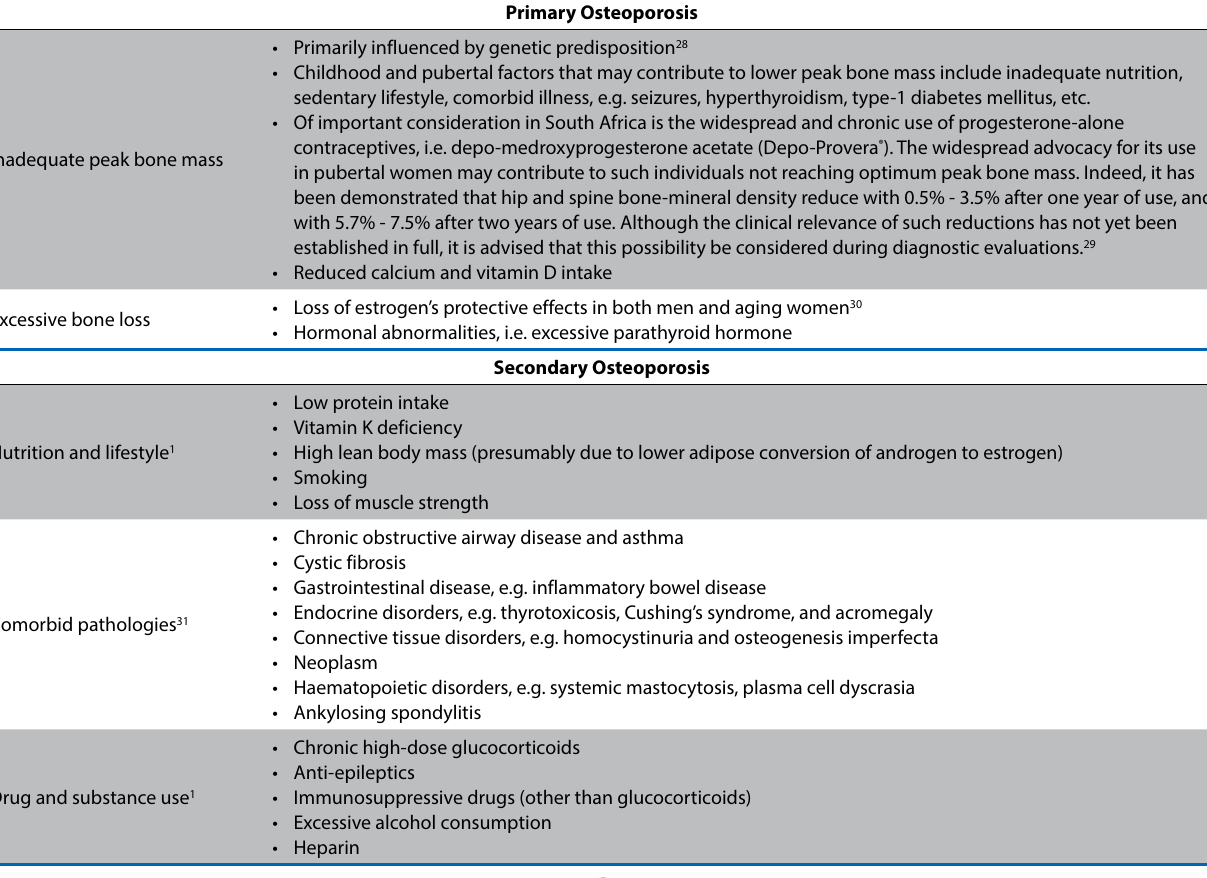
Table 2: Factors contributing to the development of primary and secondary osteoporosis